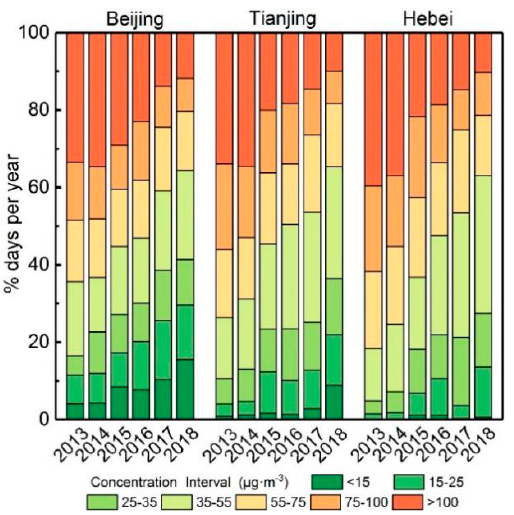
Figure 4. Annual range of daily PM 2.5 mass concentration for Beijing, Tianjin, Hebei from 2013–2018.